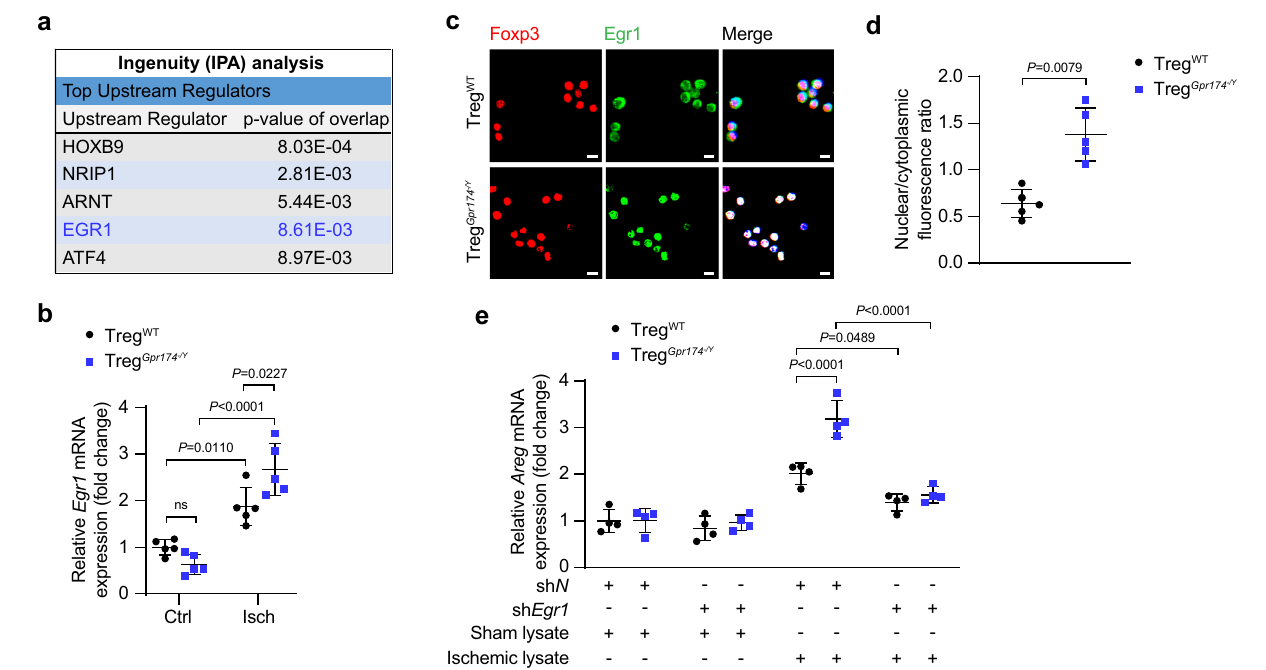
Fig. 6 | GPR174 downregulates AREG expression by inhibiting EGR1 nuclear localization.a ToptranscriptionfactorsofAREG. b Egr1 mRNAexpressioninTregs isolated from the muscle tissues of WT and Gpr174 − /Y mice 7 days after HLI ( n =5). c Representativeimmuno fl uorescentimagesofEGR1(red),andDAPI(blue)staining in Tregs isolated from the ischemic muscles of WT and Gpr174 − /Y mice 7 days after HLI.Scalebar,10 μ m. d Quanti fi cationofnuclearlocalizationofEGR1( n =5). e Areg